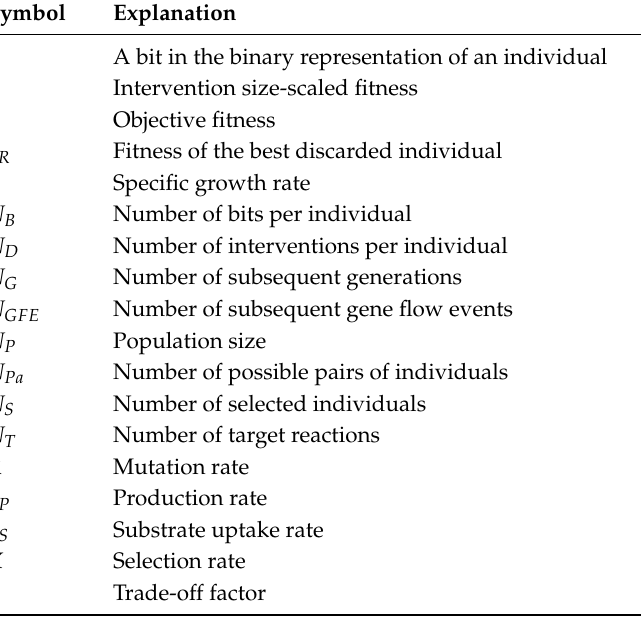
Figure S13. Hamming distance progressions for genetic algorithm runs using multiple objective functions simultaneously. Figure S14. Maximal fitness and Hamming distance progressions for genetic algorithm runs using the E. coli genome-scale model i JO1366. Table S1. Minimally- and maximally-expected, as well as standard intracellular concentrations, of gaseous metabolites. Supplementary File 2. Non-native network edges for the E. coli i AF1260 core model identified following the descriptions in the Supplementary text. Supplementary File 3. Non-native network edges for the E. coli i JO1366 genome-scale model identified following the descriptions in the Supplementary text. Supplementary File 4. Genetic algorithm parameter sets used in each conducted simulation in this work. Supplementary File 5. Collection of all relevant, identified strain